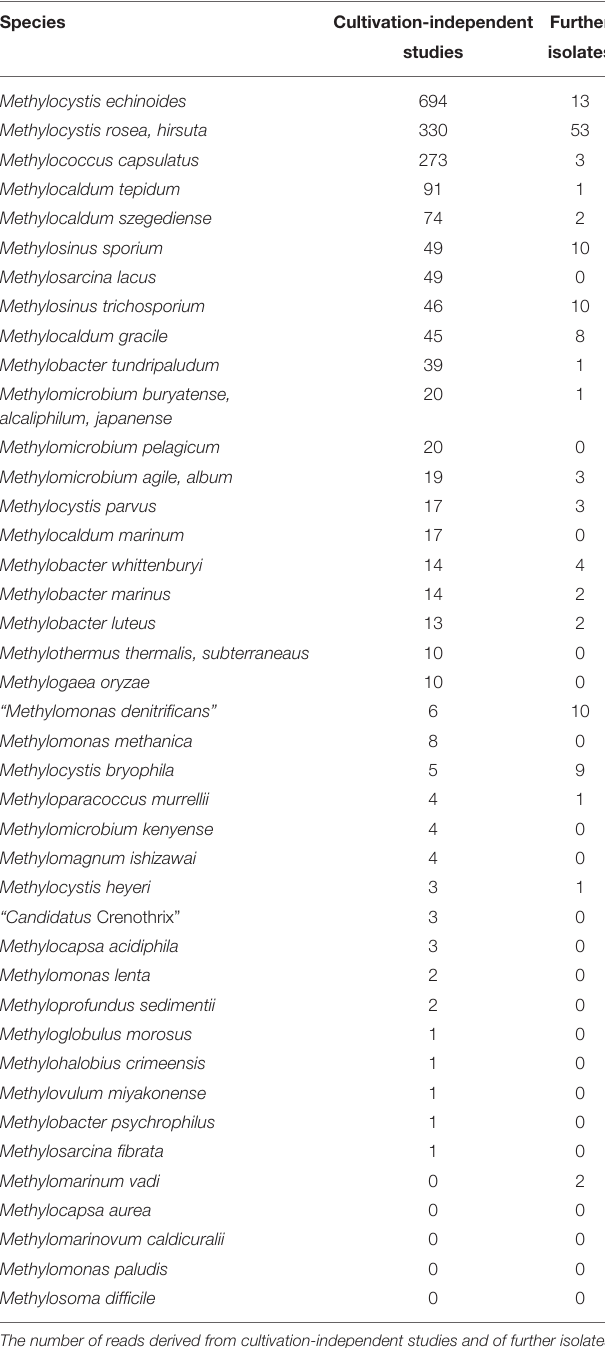
TABLE 5 | Representativeness of methanotrophic type strains at species level